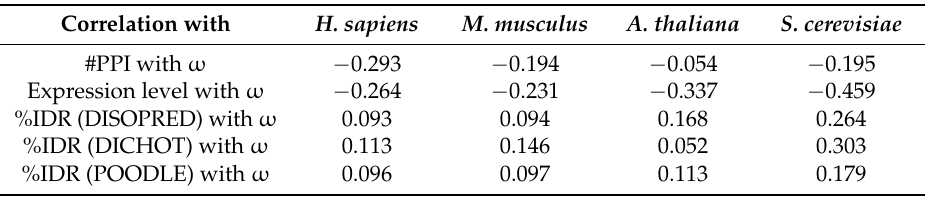
Table 2. Correlations between three properties and evolution rate ω . Correlation